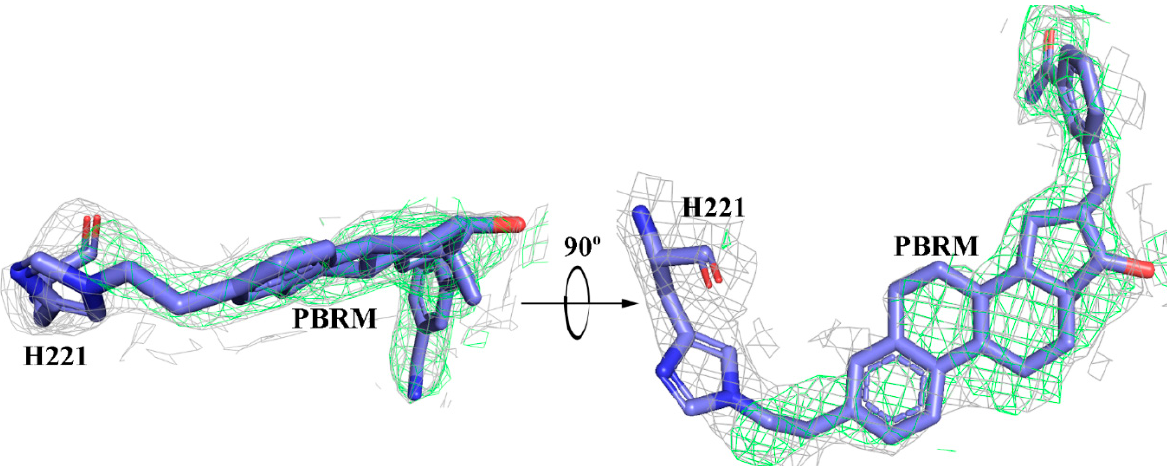
Figure 3. X-ray analysis of the complex between 17 β -HSD1 and inhibitor 1 (PBRM) shows the formation of a covalent bond with histidine-221.